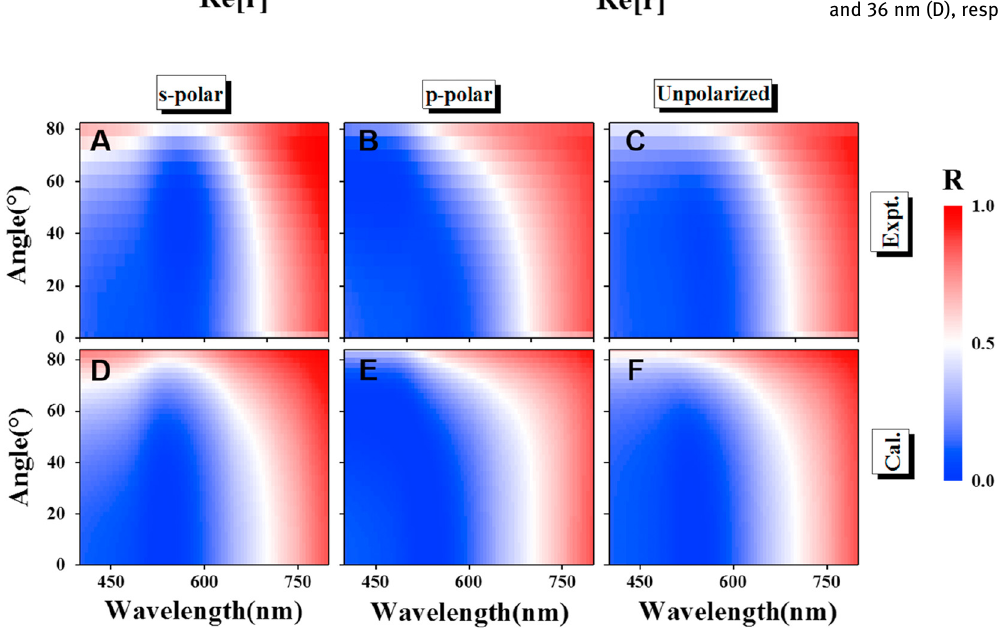
Figure 4: The partial reflected wave calculations. Calculated partial reflected waves for different thicknesses of CuO films on an optical thick Au film. The wavelength ( λ = 555 nm) and incidence angle ( θ = 0 ° ) are remain the same for the four complex phasor diagrams with h CuO equals to 12 nm (A), 20 nm (B), 30 nm (C), and 36 nm (D), respectively.